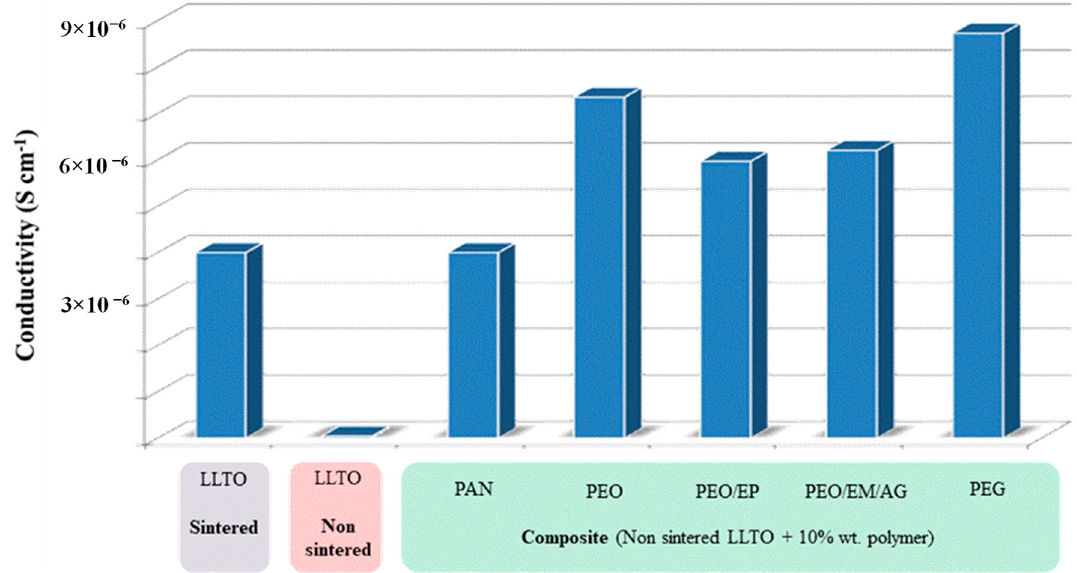
Figure 10. Total conductivity of non-sintered LLTO-polymer composites compared to both non-sintered and sintered LLTO.